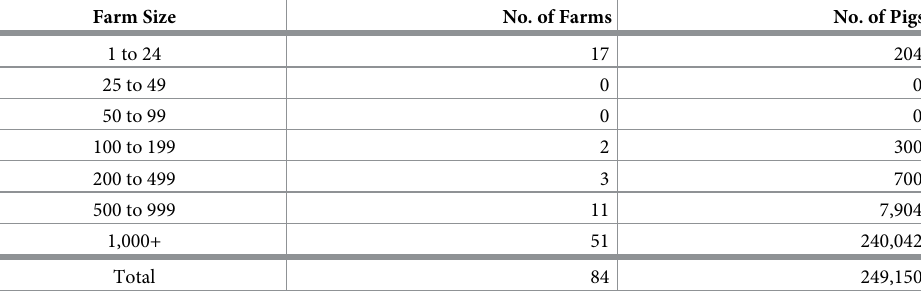
Table 4. Distribution of pigs in Stevens and Rice counties of Minnesota.